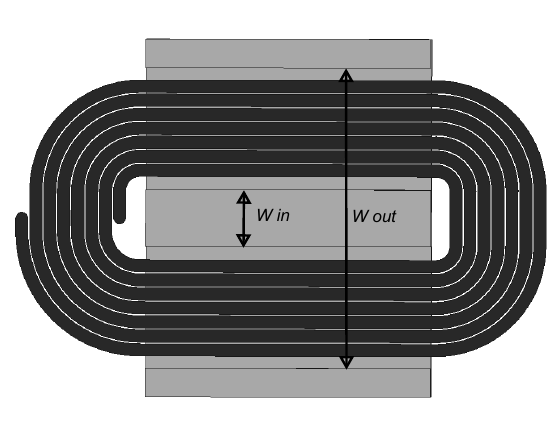
Figure 1. The printed circuit board (PCB) winding inside a planar